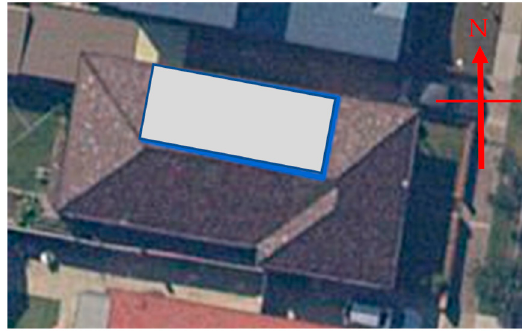
Figure 3. Selecting the usable area of the roof.